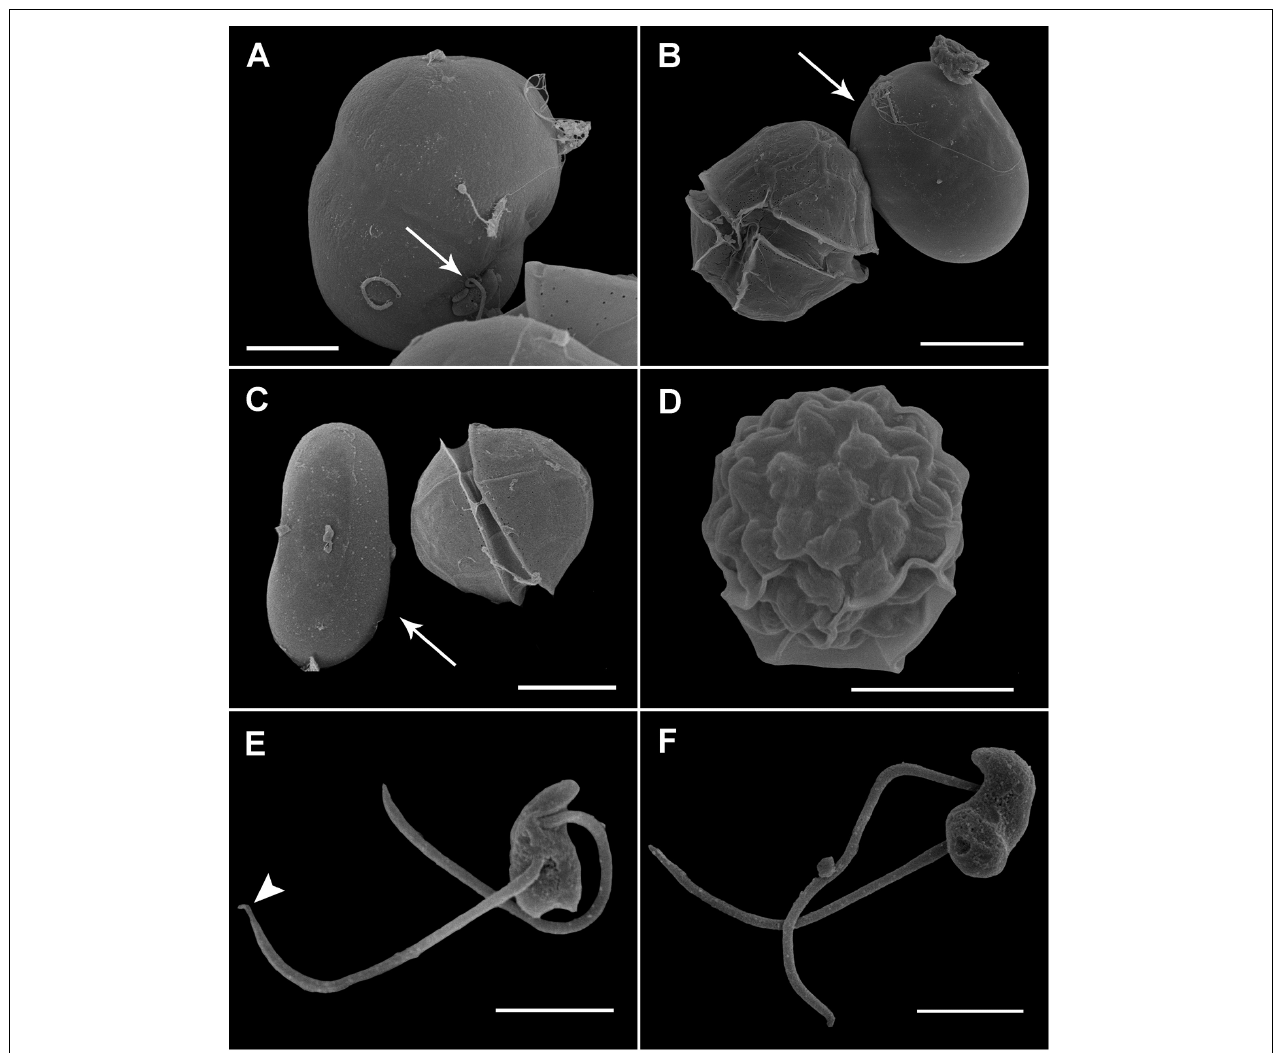
FIGURE 3 | Scanning electron microscopy (SEM) of the sporangia and zoospores of Maranthos nigrum during infection of Alexandrium minutum . (A) Zoospore (arrow) attached to the ventral area of an A. minutum dinoflagellate cell that has lost its theca. (B,C) Infected cell during trophont development (arrow), showing an elongated shape and smooth surface. (D) A mature sporangium with a collapsed outer membrane reveals the outline of the zoospores. (E) Ventral view of a zoospore showing the insertion of two flagella of similar length. The distal shrunken posterior flagellum is seen (arrowhead). (F) Dorsal view of a zoospore showing its sigmoid shape. Scale bars: (A,D) = 5 µ m, (B,C) = 10 µ m, and (E,F) = 2 µ m.